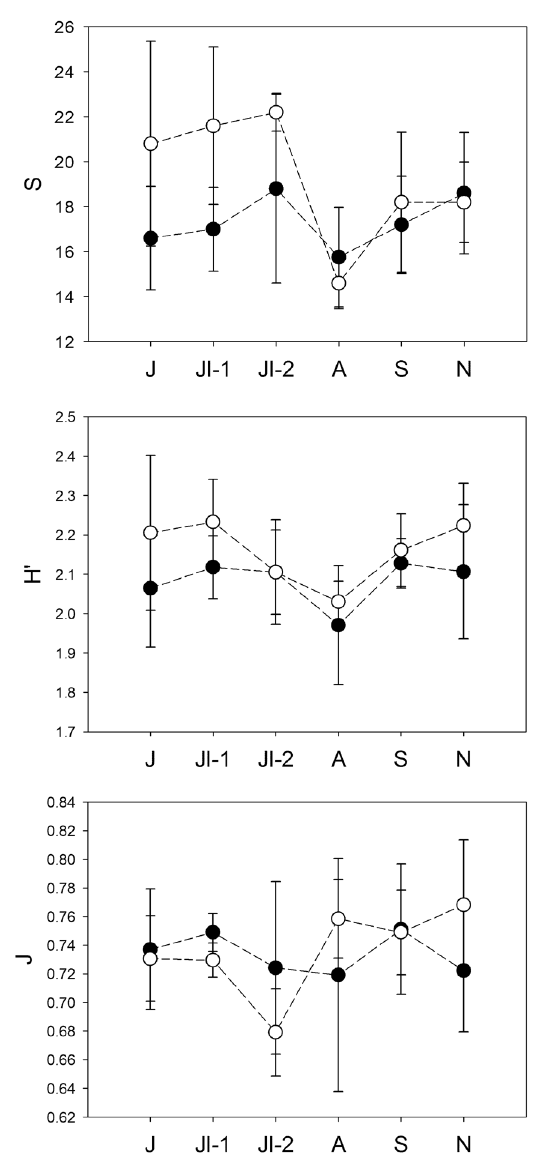
Fig . 4. – Mean (± SD) species richness (a), Shannon diversity (H’ln) (b) and Pielu’s evenness (c) at S1 (black circles) and S2 (open cir- cles) from June to November 2003 (J, June; Jl-1, first cruise of July; Jl-2, second cruise of July; A, August; S, September; N,